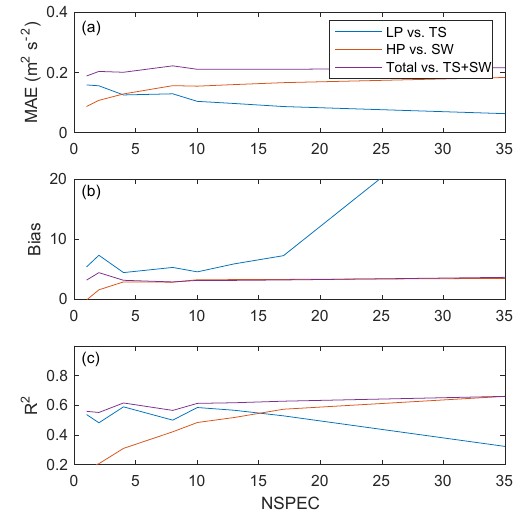
Figure 10. Same as Fig. 6 but for the 915MHz WPR. Note differ- ent vertical axis on panel (b) . All six heights are overlapping and therefore used in this